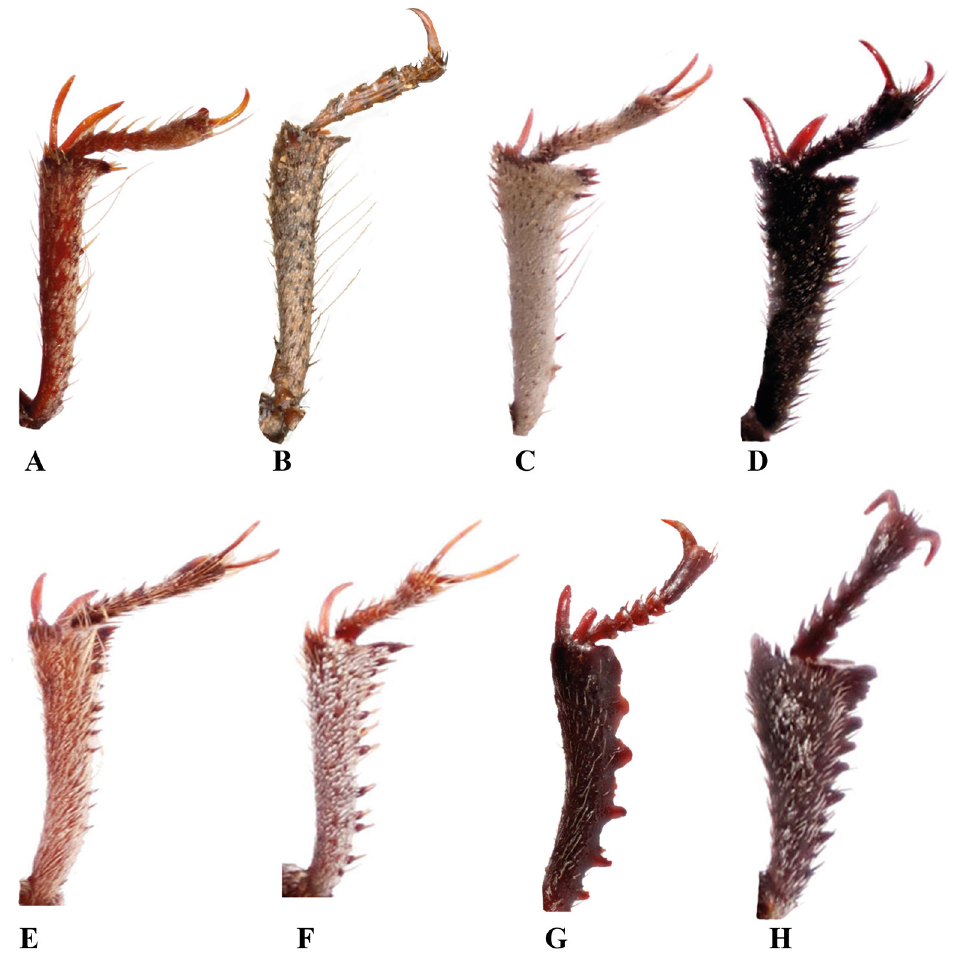
Fig. 26. Protibiae of Pimeliini, optic microscopy. A . Habrochiton vernus Semenov-Tjan-Shansky, 1907, ♂, lectotype (ZIN). B . Habrobates gabrieli (Schuster, 1935) comb. nov., paralectotype (NMB). C . Dietomorpha pardalis Kühnelt, 1957, ♂ (ZIN). D . Mantichorula semenowi Reitter, 1889, ♂ (ZIN). E . Przewalskia dilatata (Reitter, 1887), ♂ (ZIN). F . Apatopsis grombczewskii Semenov, 1891, ♀, paralectotype (ZIN). G . Earophanta serrata (Semenov, 1893), ♂ (ZIN). H . Platyope leucogramma (Pallas, 1773), ♂ (ZIN). Not to